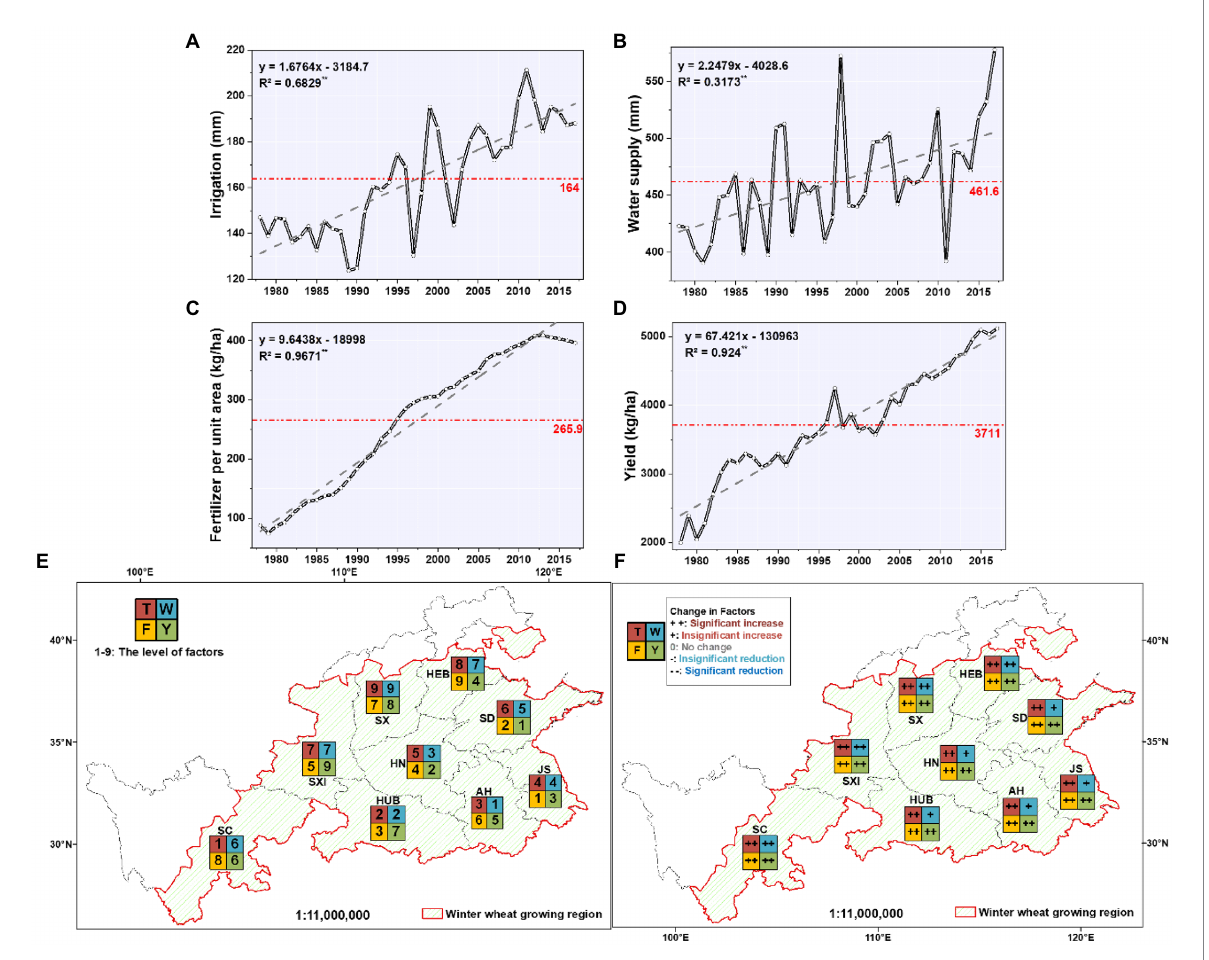
FIGURE 4 The production input level and its changes for winter wheat in China from 1978 to 2017. (A) Time series for irrigation. (B) Time series for water supply. (C) Time series for fertilization per unit area. (D) Time series of winter wheat yield per unit area. (E) Level of production factors by sorting each factor in nine provinces. (F) The changing trend of production factors in each